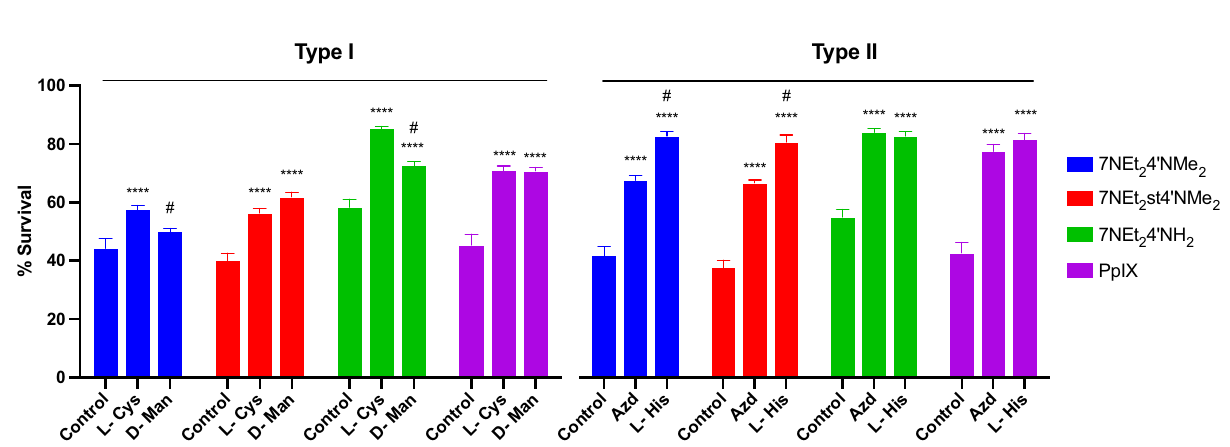
Figure 8. Mechanism of photoactivation of the compounds determined by the presence of different quenchers for type I and type II. As control the compounds were irradiated with light (6.6 J cm −2 ). For the treatments, the experiments followed the same conditions as for the photoactivation procedures but in the presence of the different quenchers (10 mM), individually. All the compounds were tested at a concentration of 50 μΜ. Each value represents the mean ± SEM (n = 8–24). *Means significantly different to the treatment control with the white light (****p value < 0.0001). # Means significantly different from the respective equivalent quencher for the same compound. To perform both statistical analysis, two-way ANOVA with Sidak’s multiple comparisons test was performed. L-Cys l-cysteine 10 mM; D-Man d-mannitol 10 mM; Azd sodium azide 10 mM; L-His l-histidine 10